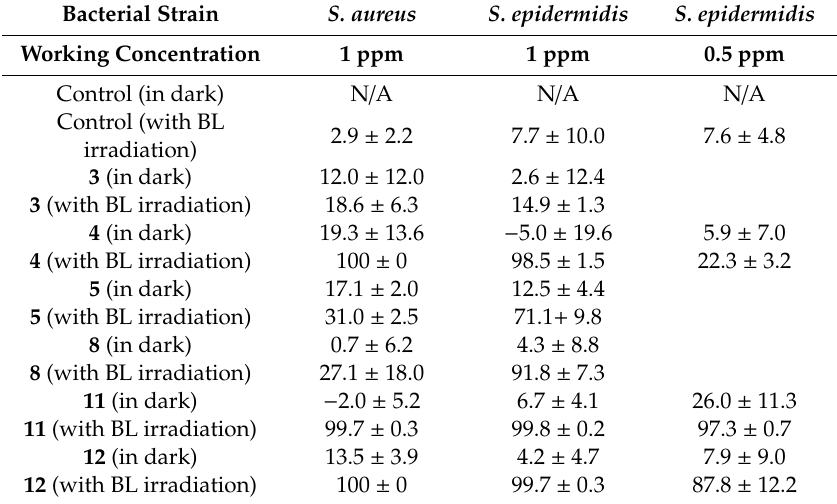
Table 1. The killing e ffi ciency of compounds 3 , 4 , 5 , 8 , 11 , and 12 against Staphylococcus aureus and S. epidermidis with 1 min blue light